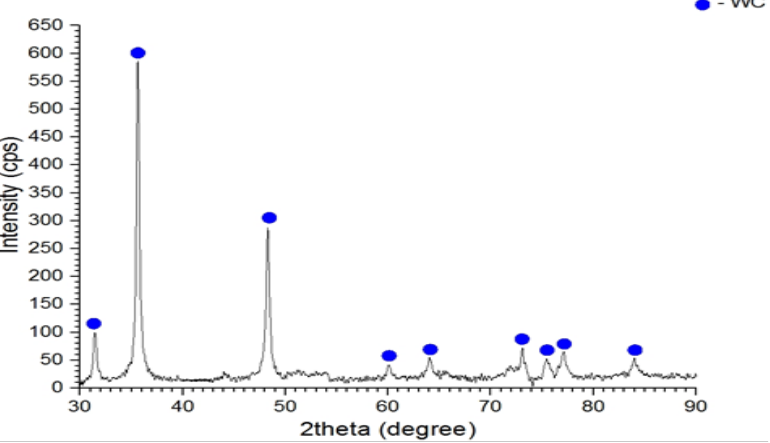
Figure 3. The representative XRD pattern of blank WC-Co substrate (cutting tool).